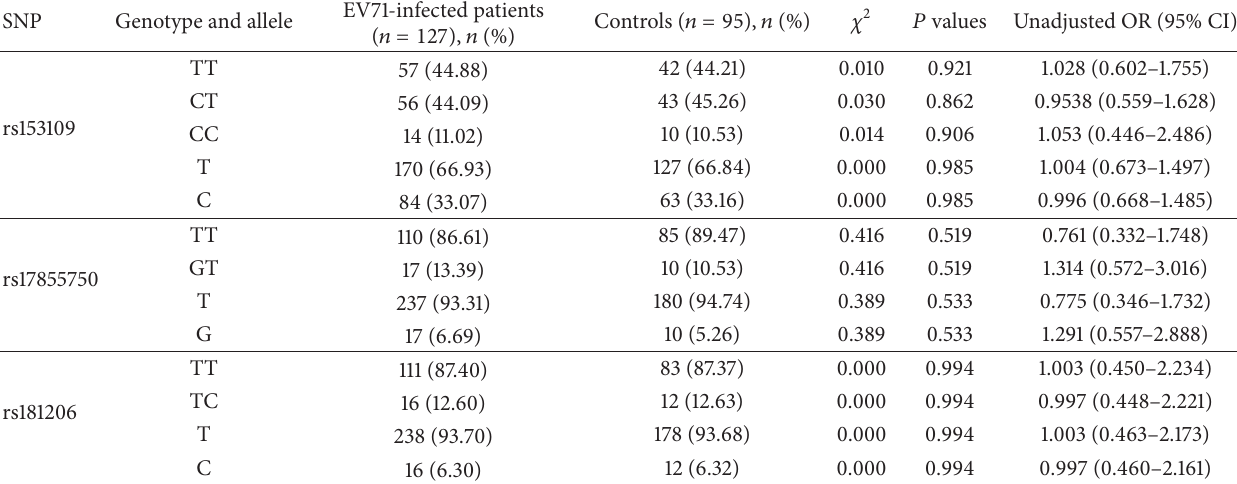
Table 2: Genotype and allele frequencies of IL27p28 polymorphism in EV71-infected patients and